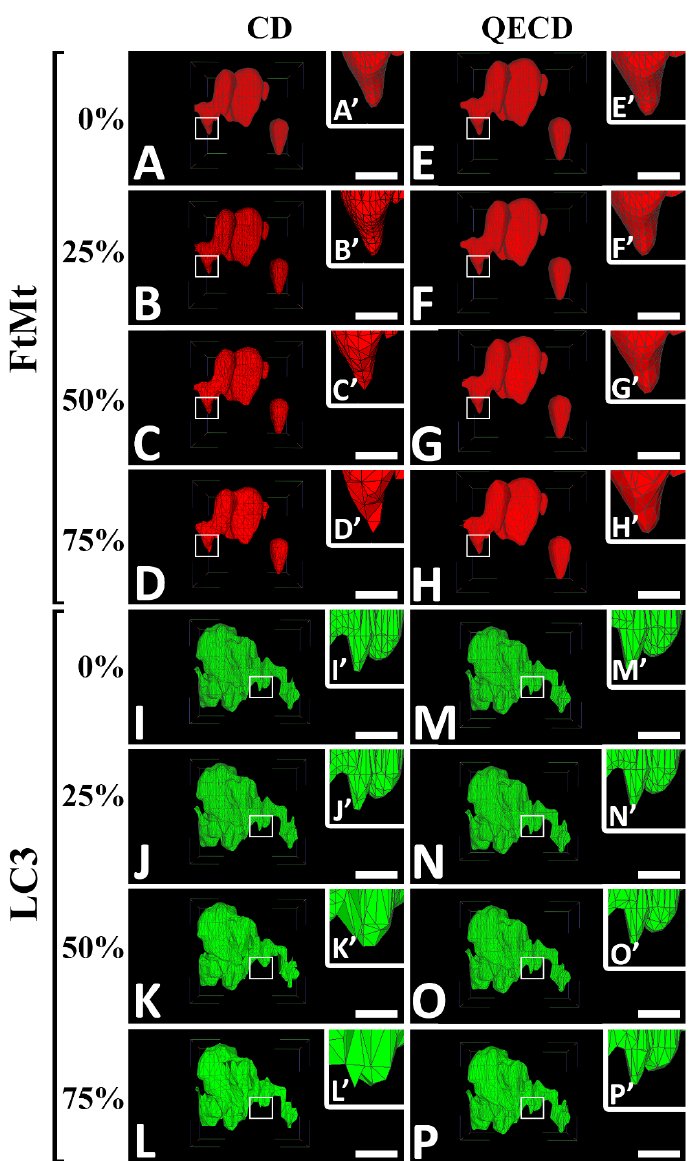
Figure 3. The shape of the FtMt and LC3 3D models before and after the simplification procedure. ( A – H ). The shape of the FtMt model at 0%, 25%, 50%, and 75% of CD and QECD simplification, respectively. ( A’ – H’ ). High-magnification image of the boxed area in ( A – H ), respectively. There was no notable change in the shape after undergoing 25% simplification through the CD and QECD. However, the shape was slightly changed with CD at 50% and 75% simplification. On the other hand, there was no noticeable change in the shape with QECD at 50% and 75% simplification. ( I – P ). The shape of the LC3 model at 0%, 25%, 50%, and 75% of CD and QECD simplification, respectively. ( I’ – P’ ). High-magnification image of the boxed area in ( I – P ), respectively. There was no notable change in the shape after undergoing 25% simplification through the CD and QECD. However, the shape was slightly altered with CD at 50% and 75% simplification. On the other hand, the shape did not change significantly with QECD at 50% and 75% simplification. All scale bars: 0.5 µ